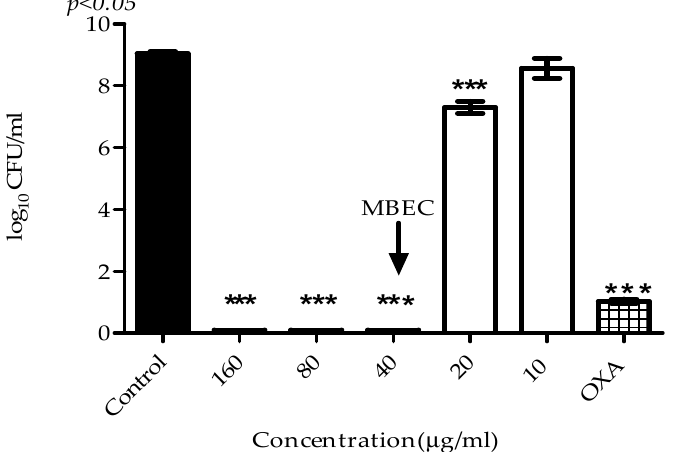
Figure 4. Effect of different concentrations of VIO on the viability of biofilm formed by S. aureus ATCC 6538P following a 24 h exposure. MBEC: minimum biofilm eradication concentration; Control: without VIO; OXA: oxacillin 20 μ g/mL. Detection limit was 10 2 colony forming units per milliliter (CFU/mL) and the assays were performed in triplicate. Data are expressed as mean ± SEM of three experiments. *** p < 0.05 compared with the control.